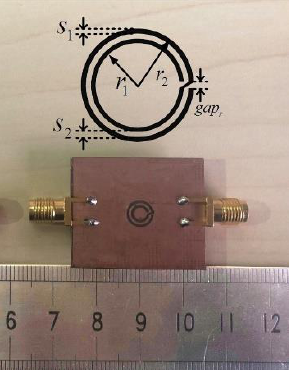
Figure 5. Photograph of the CCSR for liquid monitoring with its key dimensions.